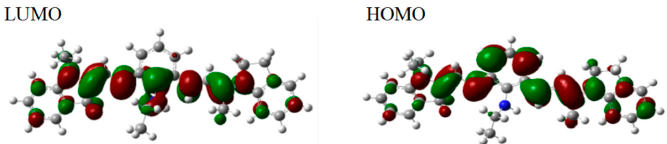
Figure 8. Calculated highest occupied molecular orbital (HOMO) and lowest unoccupied molecular orbital (LUMO) of QCy.